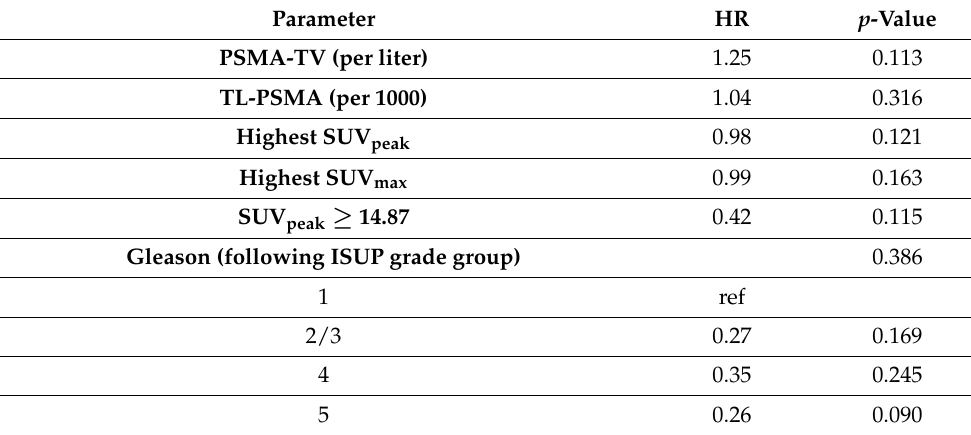
Table 7 . Univariate Cox ‐ PH regression on the patient ‐ level; significant p ‐ Values in bold . Table 7. Univariate Cox-PH regression on the patient-level; significant p -Values in bold.